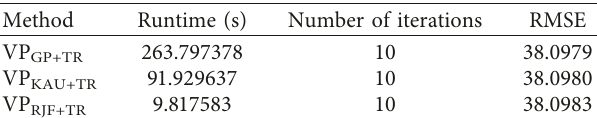
Figure 4: Change in parameters with respect to the number of iterations. (a) VP Table 4: Quantitative comparison of performance for each